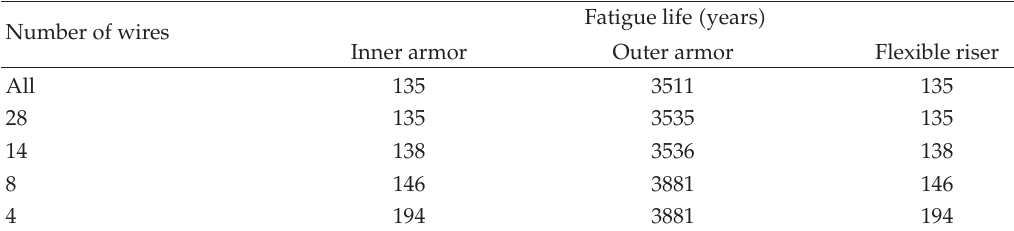
Table 4: Fatigue life: e ff ect of the number of wires